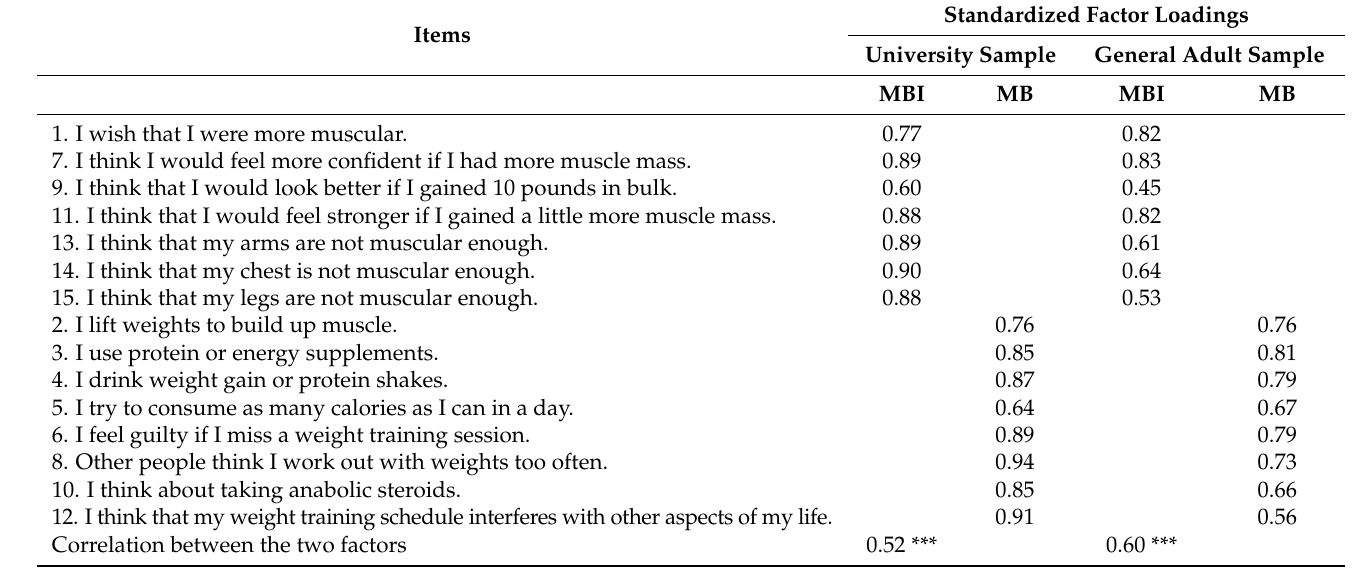
Table 2. Standardized factor loadings and factor correlation for the Drive for Muscularity Scale.